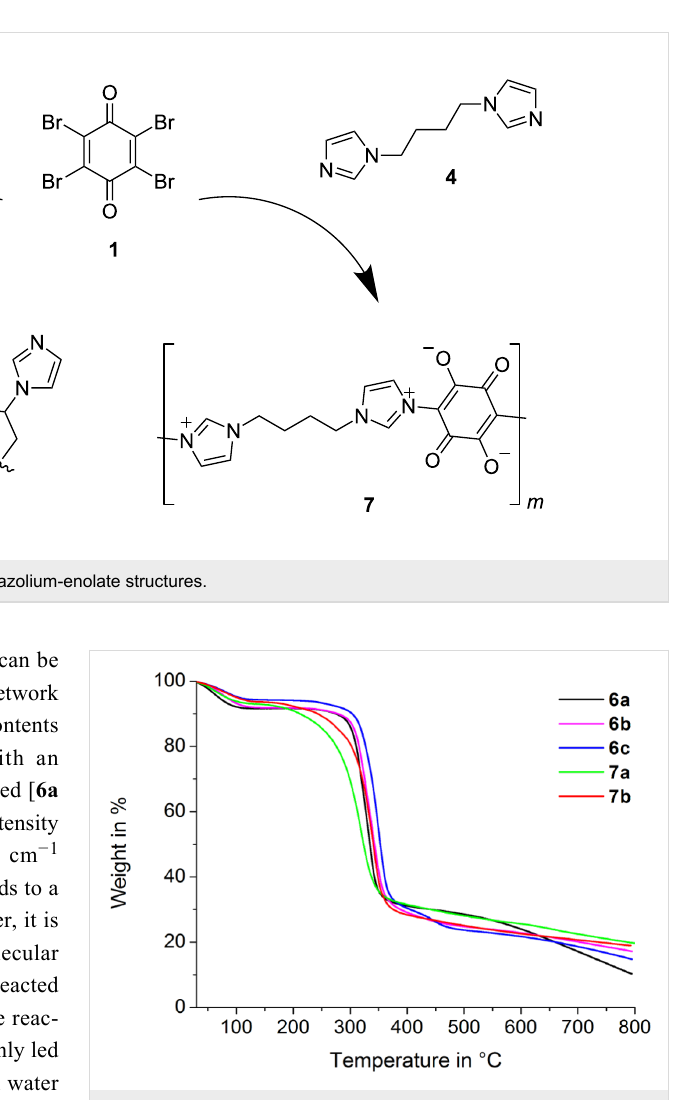
Figure 7: Thermogravimetric analyses of polymer networks 6a–c and oligomers 7a , b